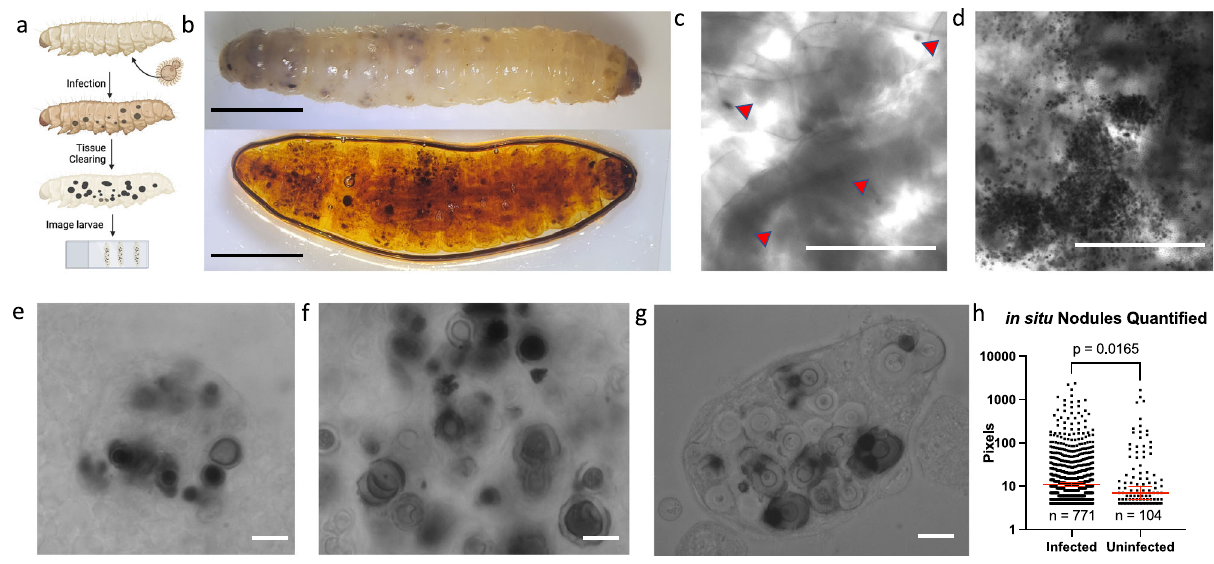
Fig. 3 Using tissue clearing to visualize the melanin-based immune response against C. neoformans in situ. Using tissue-clearing techniques ( a ), we allowed for better visualization of melanized nodules within the intact G. mellonella, as seen in a before (top) and after (bottom) view of the same infected larvae ( b ). Under microscopy, the uninfected larvae had little to no melanized nodules (red arrows indicate dark, irregular, or opaque areas in the tissue) ( c ), whereas the C. neoformans larvae had very clear and distinct nodules ( d ). These nodules were viewed under high magni fi cation, where the nodule structure and encapsulated fungus were apparent ( e , f ). These structures were very similar in appearance to the nodules extracted from hemolymph ( g ). h The size of the melanized nodules were quanti fi ed using particle measuring software. Infected particles represent n = 771 independent particles, uninfected particles represent n = 104 independent particles, (Mann – Whitney test, p = 0.016). Error bars signify median with 95% Con fi dence Interval. i The melanized nodules of C. neoformans appeared to have no tissue tropism, but were found in distinct clumps or areas throughout the larvae (red arrows). b – g , i are representative images from three biological replicates. Scale bars in e – g , i represent 10 µ m, c , d represent 500 µ m, and b represent 50 mm.